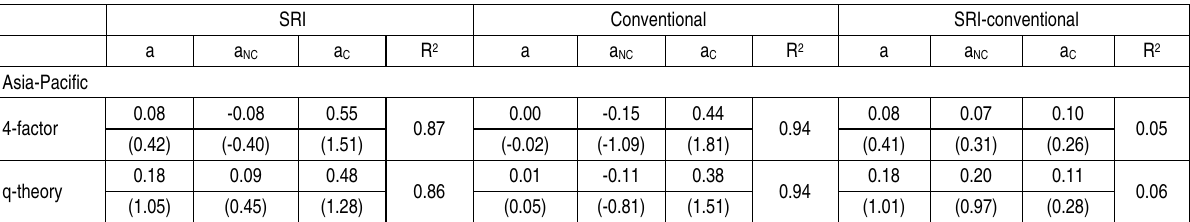
Table 3 (cont.). Financial performance: alpha estimates of the North American, European, and Asian-Pacific sub-portfolios in percent per